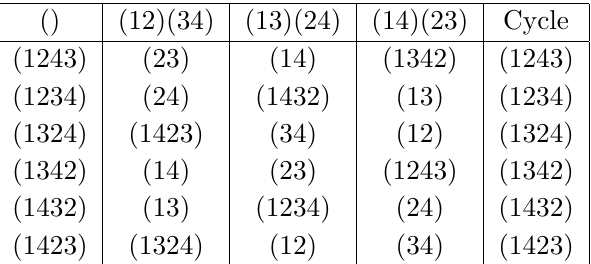
Table 10 . Right multiplication of fV